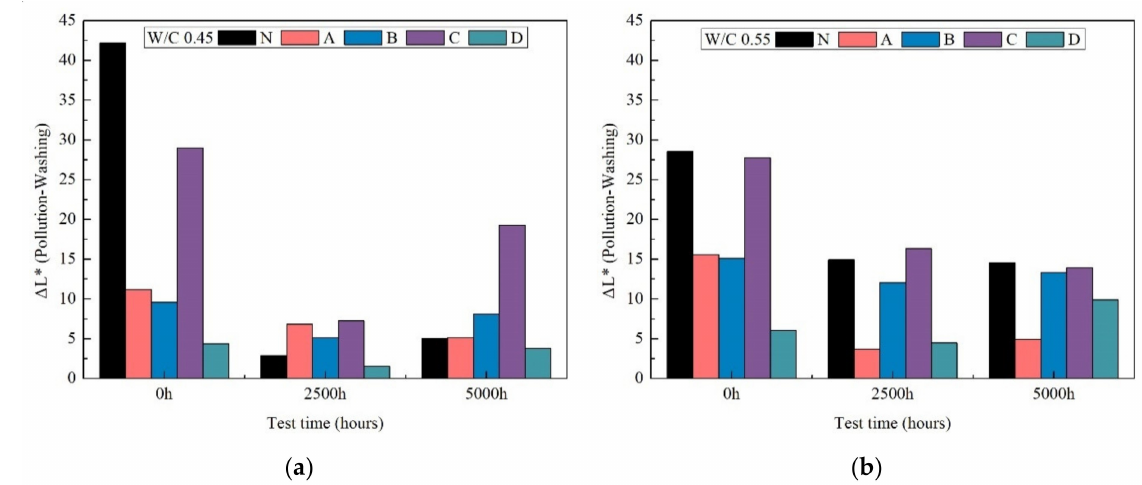
Figure 11. The brightness difference after accelerated fouling tests of 0 h, 2500 h and 5000 h weathering for w/c ratio 0.45 ( a ) and 0.55 ( b